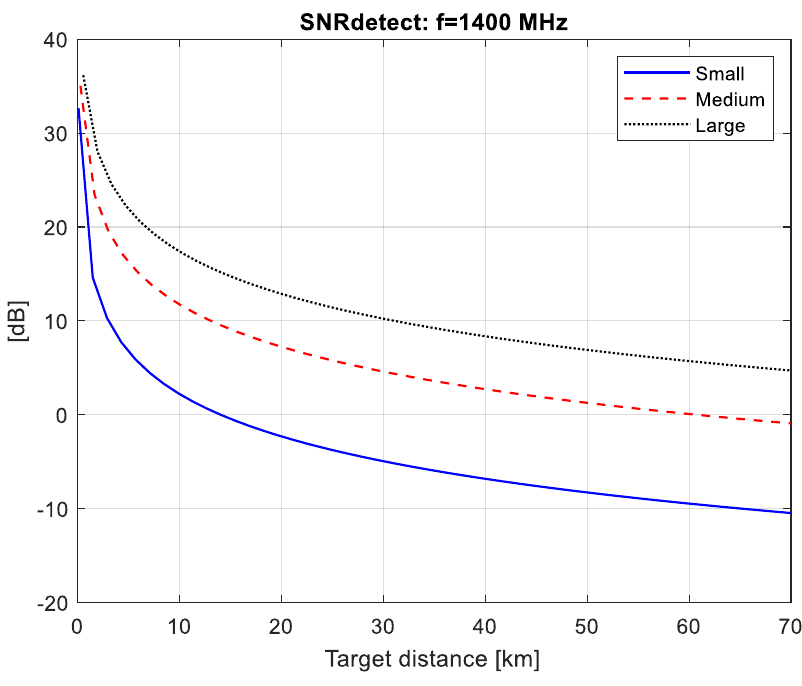
Figure 6. SNR det values for lunar FSR. Figure 6. 𝑆𝑁𝑅 𝑑𝑒𝑡 values for lunar FSR.